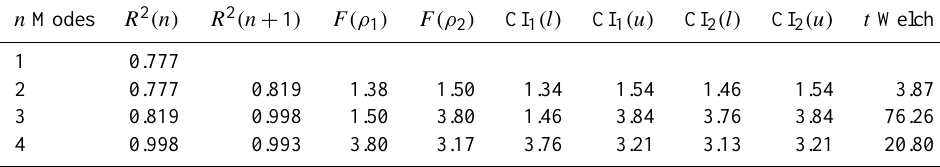
Table 2. Statistical testing of R 2 during application of the GMM fit to the interpolated AVSD of dominant marine (sea salt) aerosol at Lanai, Hawaii, on 21 January 2002. In the case of a single mode, statistical testing is not performed. In the case of both n = 2 and n = 3 modes, the lower confidence limit CI 2 (l) of the larger-valued F(ρ 2 ) is less than the upper confidence limit CI 1 (u) of the lower-valued F(ρ 1 ) , and the t Welch statistic being > 1.96 shows that there is a statistically significant improvement in R 2 . In the case of n = 4 modes, two things should be noted: firstly, that F(ρ 2 ) < F(ρ 1 ) (i.e. a reduction in the improvement in the goodness of fit). Secondly, since the lower confidence limit CI 1 (l) of the larger-valued F(ρ 1 ) is greater than the upper confidence limit CI 2 (u) of the lower-valued F(ρ 2 ) , this reduction is statistically significant; i.e. the addition of the fourth mode worsens the fit, and the optimal number of modes is therefore n =